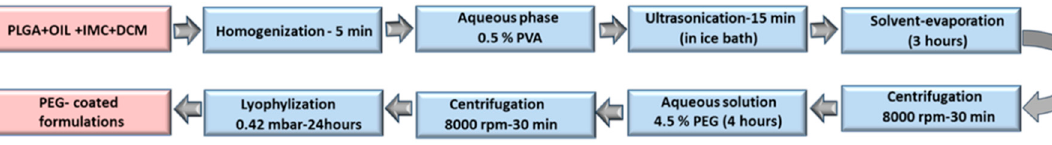
Figure 1. The chart flow of the preparation process.